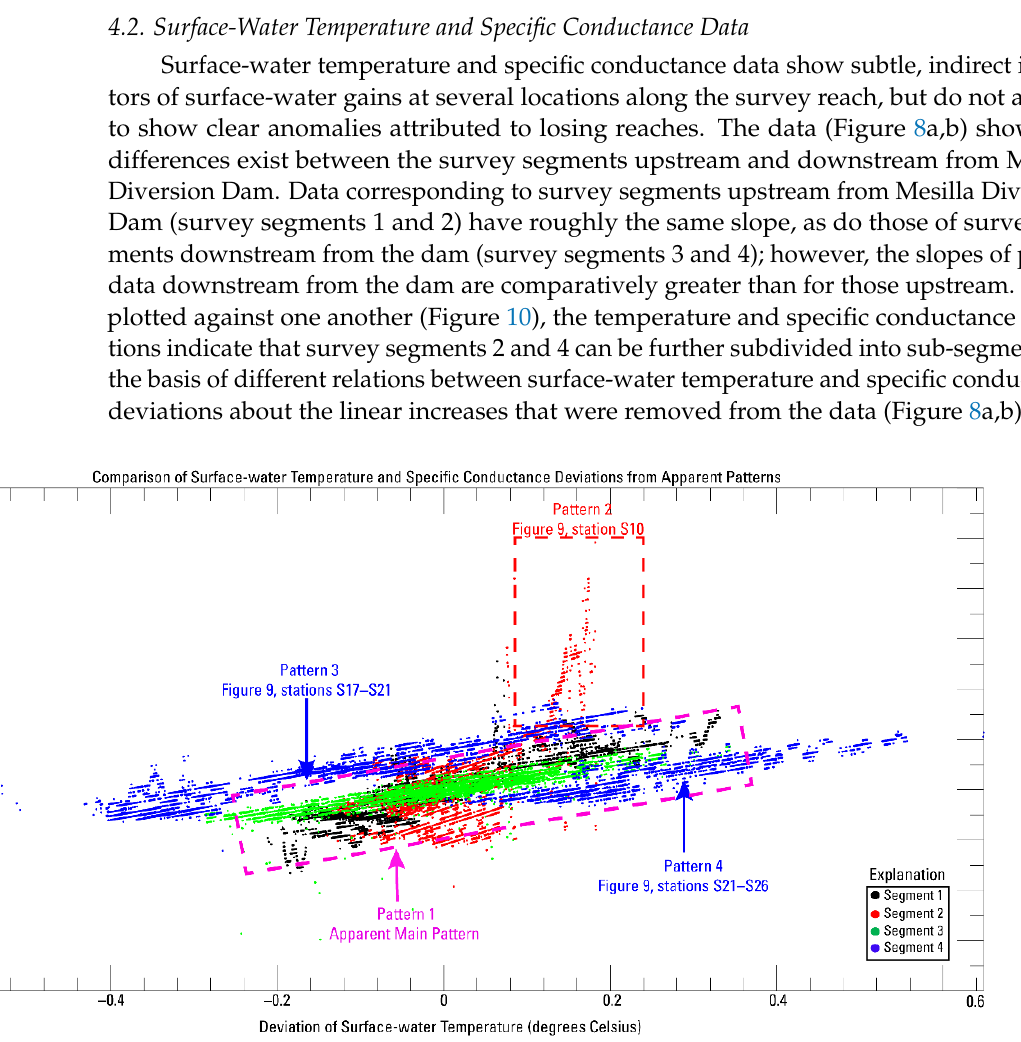
Figure 10. Scatter plot of specific conductance deviations versus temperature deviations showing different relations exist between surface-water temperature and specific conductance along survey segments 2 and 4.